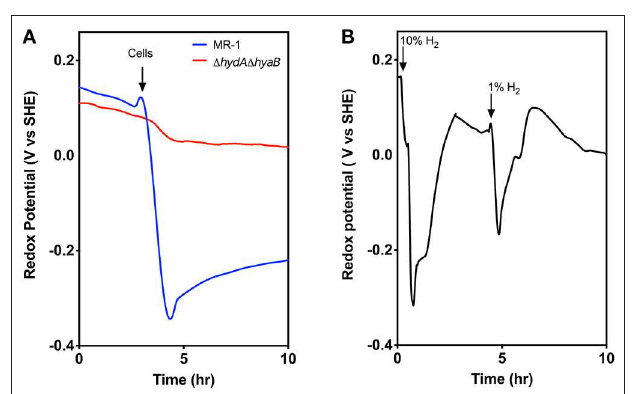
FIGURE 4 | Evidence for hydrogen disposal by MR-1 cells after transfer to Fe(III) oxide containing medium. (A) Redox probe based measurements detect a rapid decrease in redox potential when MR-1 cells with excess lactate are exposed to Fe(III) oxide as an electron acceptor. In contrast, 1 hydA 1 hyaB mutants do not lower redox potential, consistent with a burst of produced hydrogen by wild type cells experiencing donor-excess conditions. Fe(II) reduction at this early time point was minimal and similar by both strains (data not shown). (B) Abiotic control experiments showing similar rapid drop in redox potential in Fe(III) oxide medium in response to small additions of hydrogen to the headspace of reactors, and removal by flushing. Data is representative of three